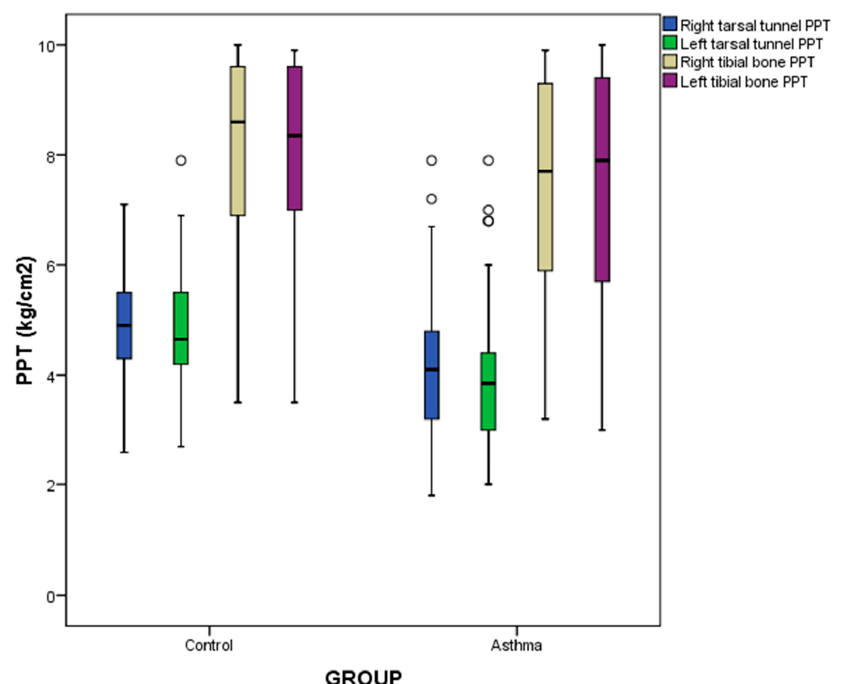
Figure 1. Box-plots to illustrate bilaterally tibial bone and tarsal tunnel PPT differences between patients diagnosed with asthma and healthy matched-paired controls. Abbreviations: PPT, pressure pain threshold.